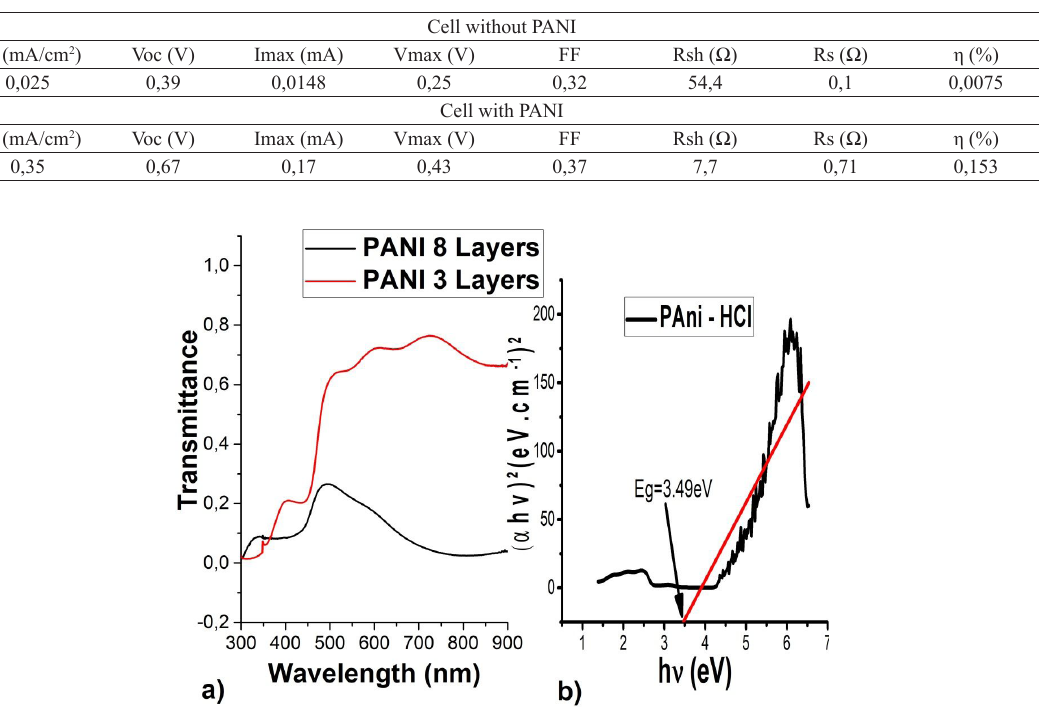
Figure 8. Transmittance graph and Bandgap graph of PANI. Source: the author.